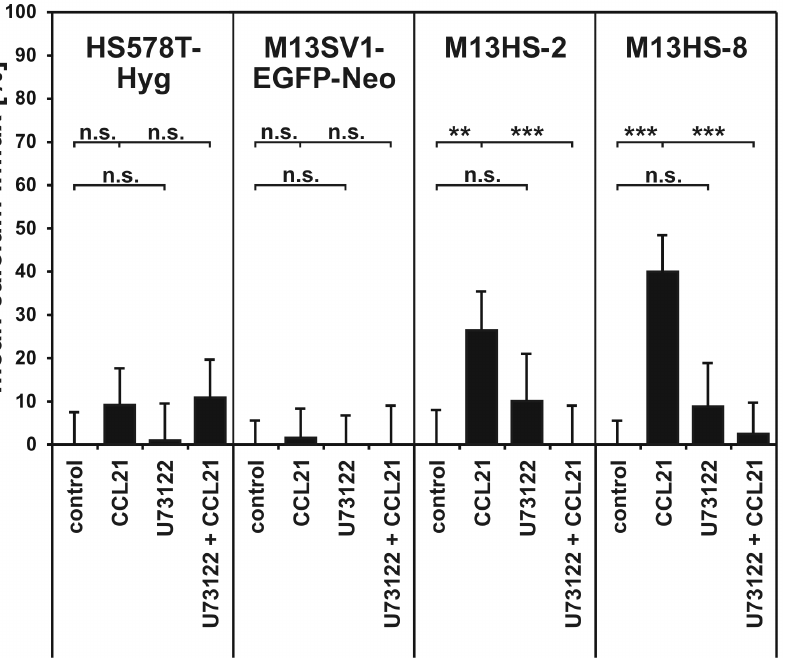
Figure 3. Calcium measurements. The diagram shows the mean calcium influx in CCL21 stimulated cells. An increase in cytosolic calcium levels was only observed in M13HS-2 and M13HS-8 hybrid cells. To prove whether the CCL21 induced calcium influx in these cell lines depended on PLC- b / c activity, appropriate calcium measurements within the presence of 5 m M U73122 were performed. Cells were preincubated for 5 minutes with U73122 prior to analysis. Shown are the mean 6 SD of n=3 independent experiments. Statistical significance was calculated using Student’s t -test: n.s. = not significant; ** = p , 0.01; *** = p , 0.001.